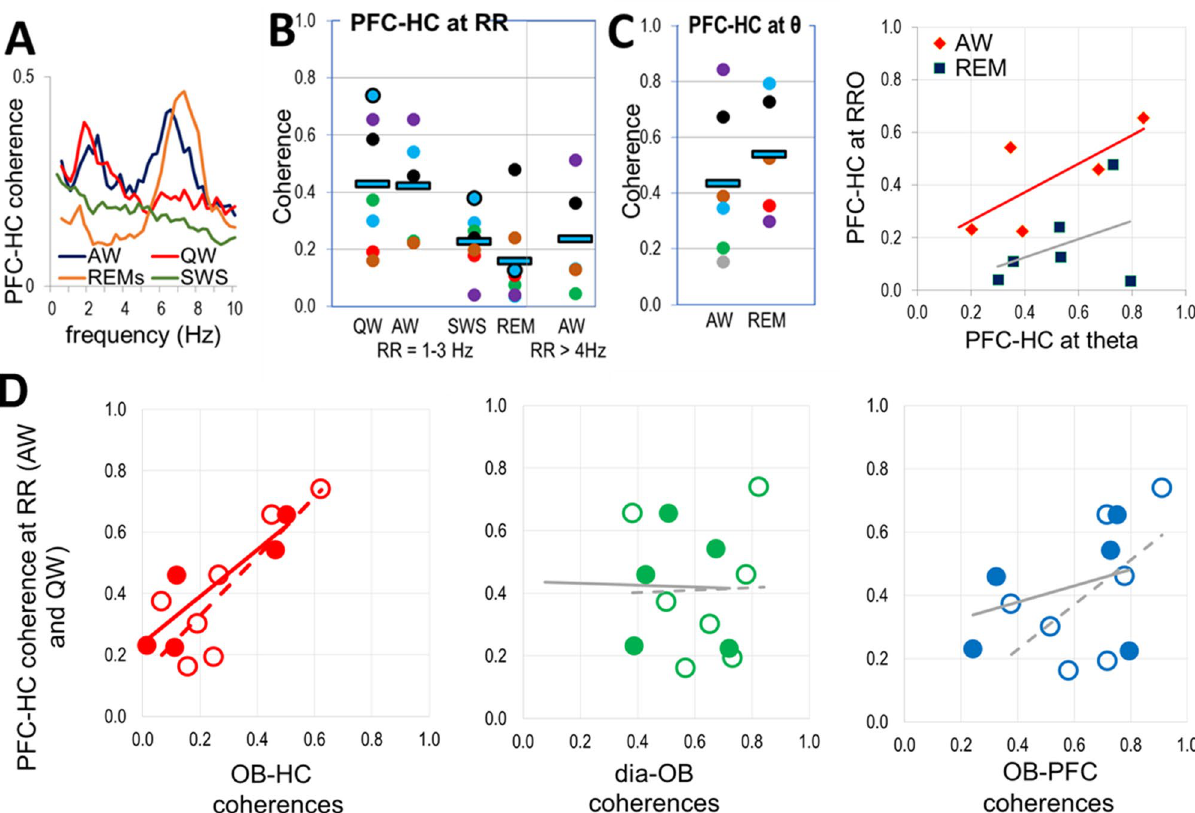
Figure 3. Coupling of PFC and HC networks by RRO. ( A) PFC-HC coherences at the respiratory frequency (RRO) in different states. ( B) PFC-HC coherences at RRO in awake (QW, AW) and sleep states (SWS, REM) at RRO (1–3 Hz). Squares: group averages, dots: individual experiments; same colors were used for individual rats in different states (same colors as in Fig. 2A). ( C) Distribution of PFC-HC coherences at theta (6–8 Hz) frequency and it’s relationship to RRO coherences in theta states. ( D) Correlation between RRO coherences connecting PFC and HC vs. RRO coherences connecting OB to HC, dia, and PFC signals in AW (filled symbols and solid trendlines) and QW (open symbols and dashed trendlines) recordings at RRO frequency. Significant correlations are shown in the color of the corresponding dots, and trendlines of nonsignificant correlations are shown in